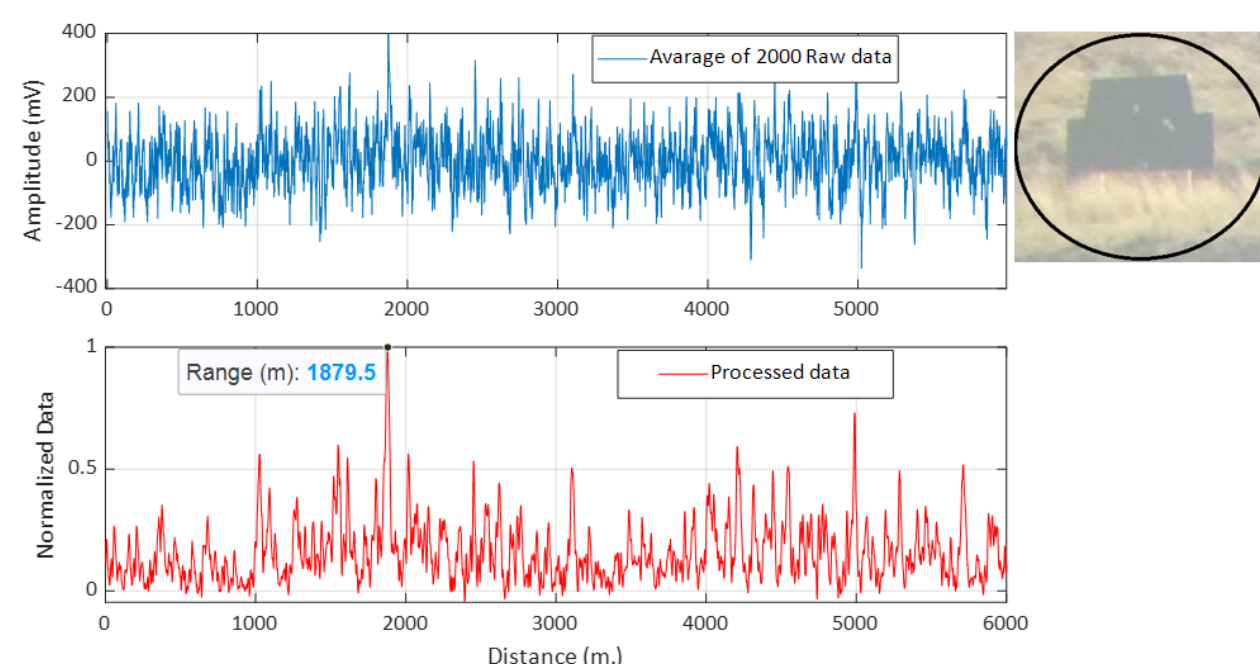
Figure 8. Average raw data ( top ) and processed data ( bottom ). The range found with our own LRF is 1879 m. The number of averaged raw data frame, N is 2000.